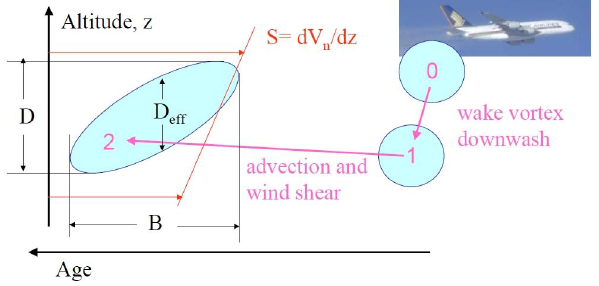
Fig. 1. Schematic of contrail dynamics versus altitude and con- trail age with plume depth D , breadth B , and normal velocity shear dV n /dz at stages 0: contrail formation, 1: downwashed wake vor- tex, 2: aged Gaussian cross-section.